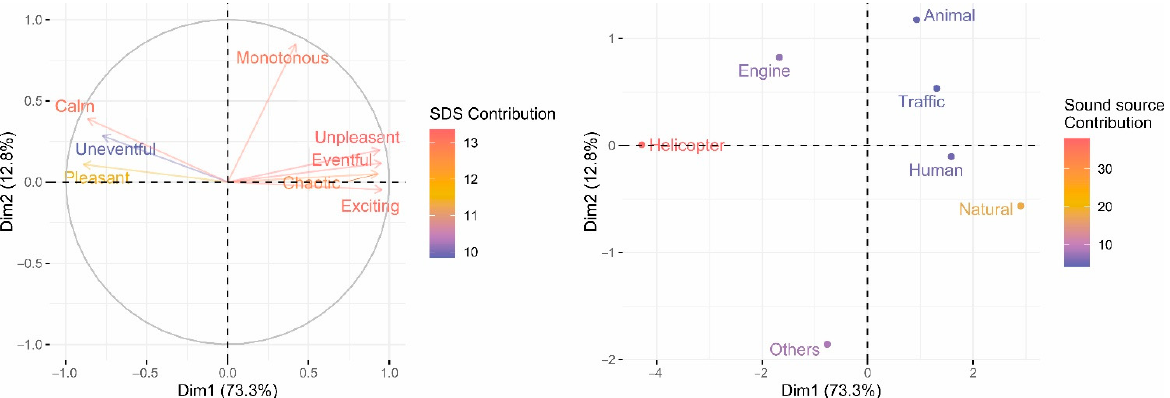
Figure 9. Component scores of the 8 semantic differential scales (SDS) ( left ) using the noise sources as loading scores ( right ). Blue to red scales were used to represent the contribution of each variable.